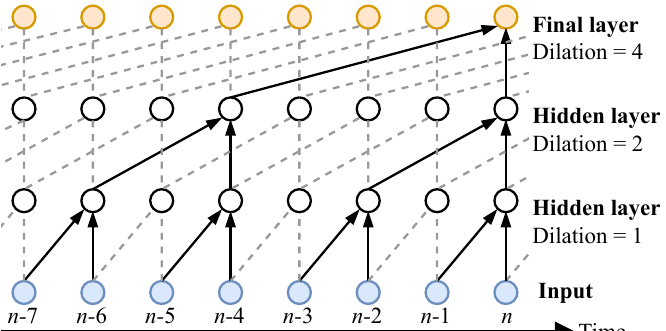
Figure 3. Visualization of three convolutional layers in series and the resulting receptive field of N = 8. The figure has been adapted from